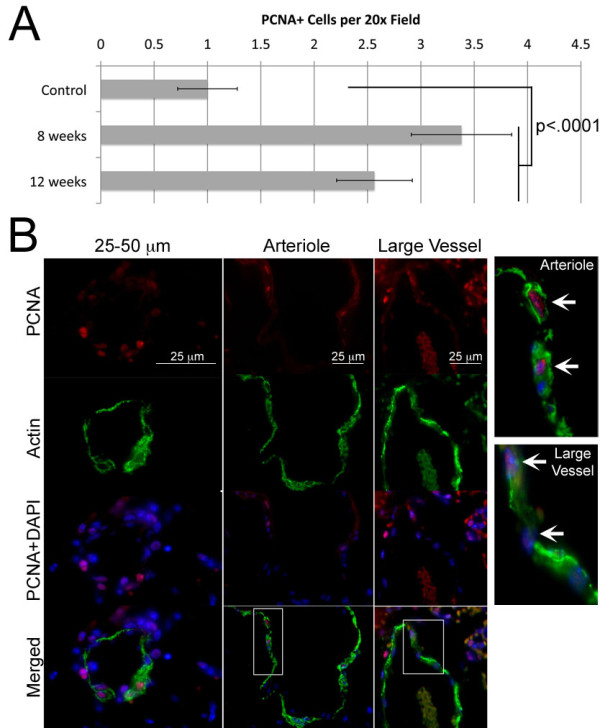
(A) Quantification of nuclei with PCNA staining substantially greater than the median by histology indicates strong increases in proliferation in Tie2- Bmpr2delx4+ mouse lung (p < .0001 by ANOVA with post-hoc t-test; no significant difference between 8 and 12 week time points) (B) Representative fields demonstrate that increased PCNA staining is found in vessels of all sizes.